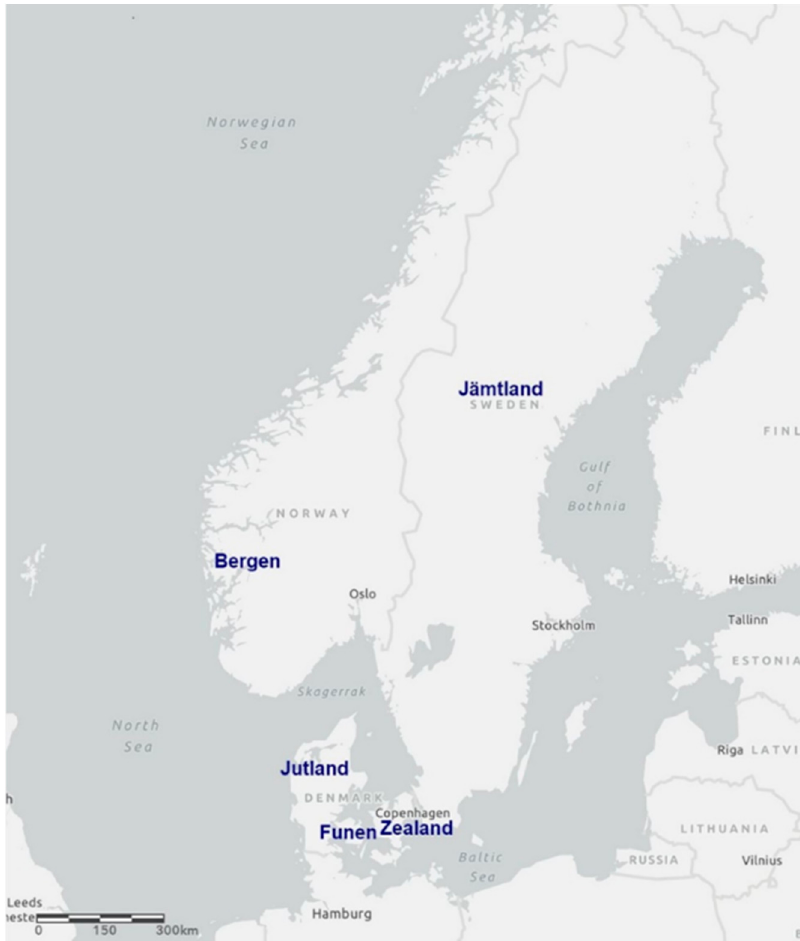
Figure 2. Map of Scandinavia, with some key locations discussed in this